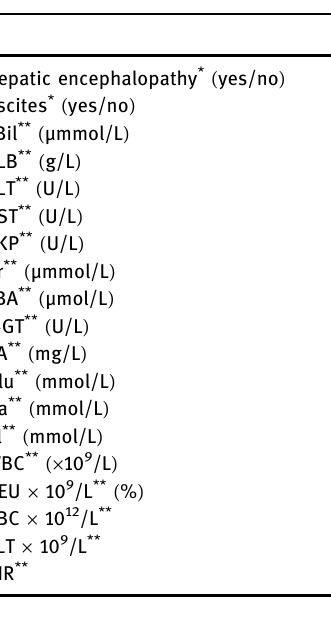
Table 2: Clinical indicators of patients ( baseline )